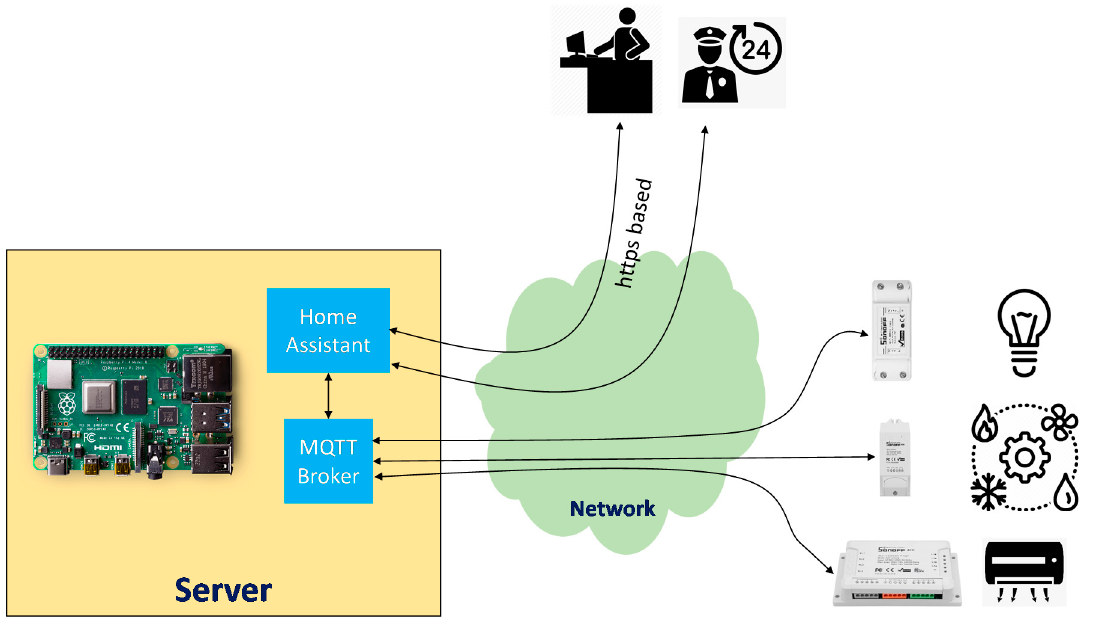
Figure 11. Architecture of the monitoring and control platform with MQTT (Message Queuing Telemetry Transport) protocol.